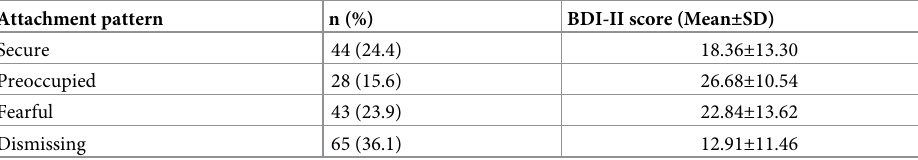
Table 2. Attachment pattern and BDI-II score.